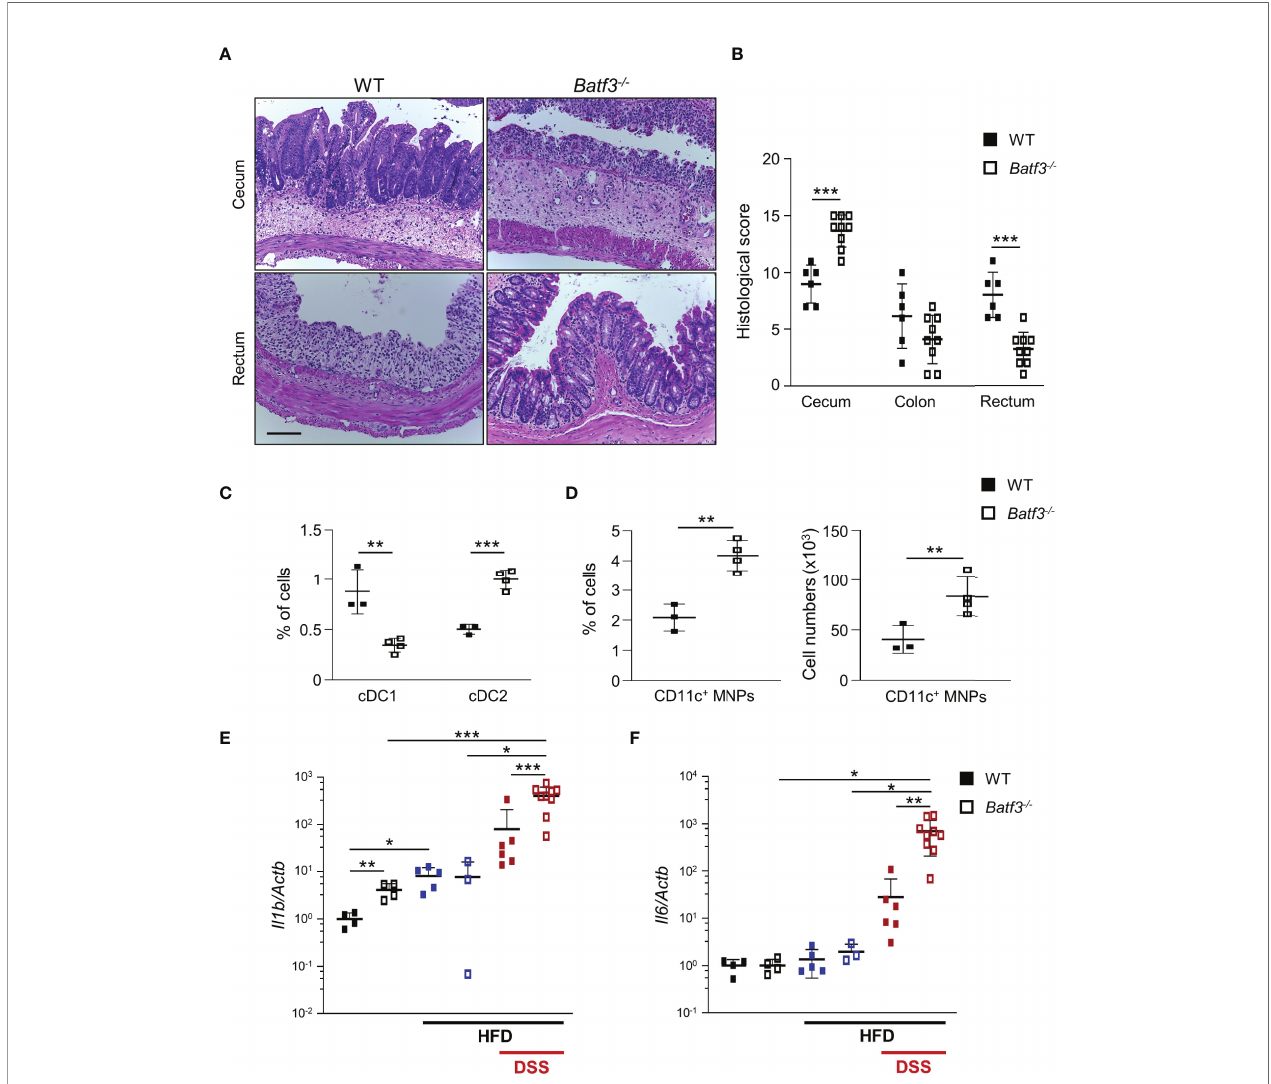
FIGURE 4 | High-fat diet exacerbates DSS-induced acute colitis in Batf3 -/- mice. (A) Representative H&E staining of cecum and rectum from WT and Batf3 -/- mice receiving high fat diet (HFD) for 8 weeks followed by 7 days of DSS drinking water (Scale bar, 100 m m). (B) Histological scores for cecum, colon, and rectum (n = 6- 9/genotype). (C, D) Percentages of lamina propria cDC1, cDC2 (C) , and CD11c + MNPs, percentage of cells (left panel), total number of cells per large intestine (right panel) (D) measured by fl ow cytometry (n = 3-4/genotype). One representative experiment out of two independent experiments is shown. (E, F) mRNA expression of Il1b (E) and Il6 (F) in the cecum of 16-week-old mice on normal chow, receiving HFD, and receiving HFD and 7 days of DSS as measured by qPCR. All data were normalized to expression of Actb and represented as fold changes compared to WT mice (NC: n = 4/genotype; HFD: n = 3-5/genotype; HFD + DSS: n = 6-9/ genotype). Data are represented as means ± SD. Statistical signi fi cance was determined by Student ’ s t -test. *, p < 0.05, **, p < 0.01, ***, p <